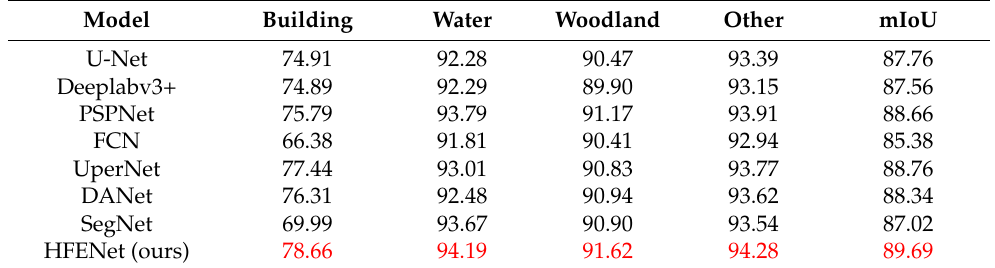
Table 8. The IoU values for each category of the state-of-art models on the landcover.ai (%).